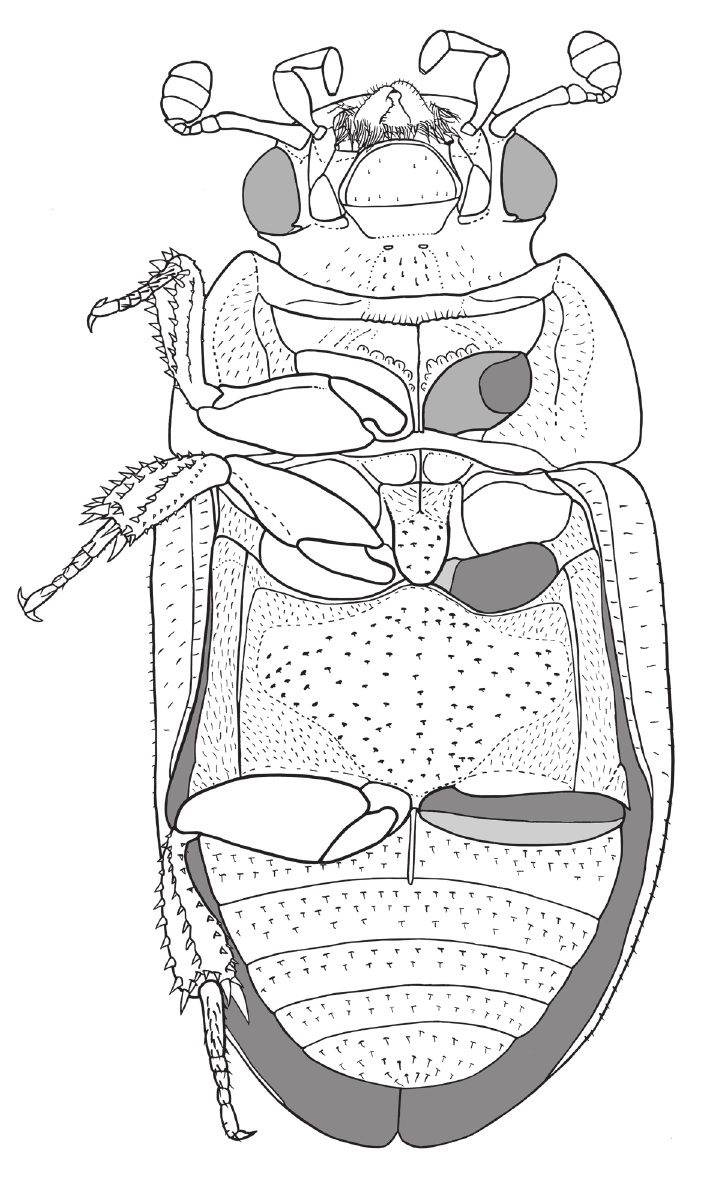
Figure 3. Evanesternum pulsatum (d’Orchymont) scheme of ventral morphology. slightly longer than parameres, asymmetrically narrowing basally, base slightly curved. Parameres weakly narrowing apically, subsinuate and briefly widened near apex. Me- dian lobe (Fig. 1d) narrow, parallel-sided throughout, apex acuminate, with small par- allel apical projection, gonopore moderately large, situated